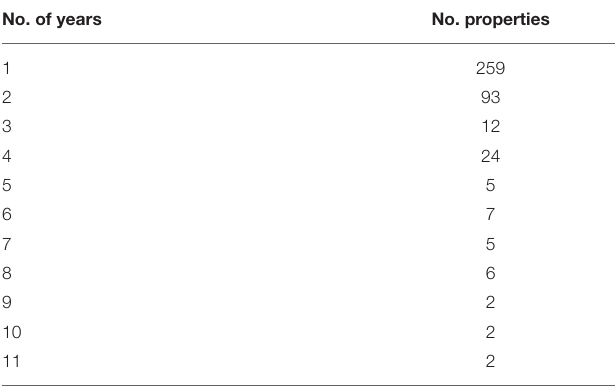
TABLE 3 | Frequency of butterfly surveys at each site, Iowa,